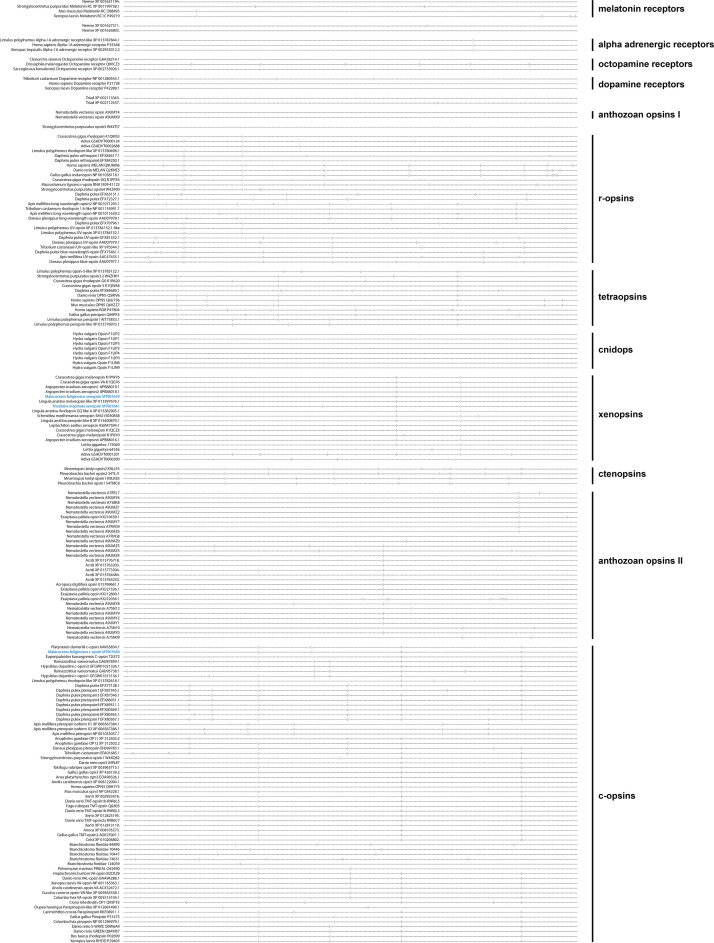
Intron phase and position of all sequences, which were used for gene tree calculation and for which genomic information was available or generated in this study, mapped on the un-curated protein sequence.The sequences investigated in this study are highlighted in blue.